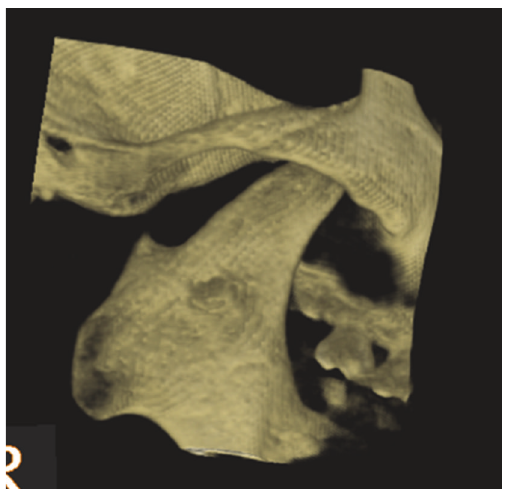
Figure 8: 3D CBCT right oblique lateral shows absence of glenoid fossa and complete absence of the condyle.